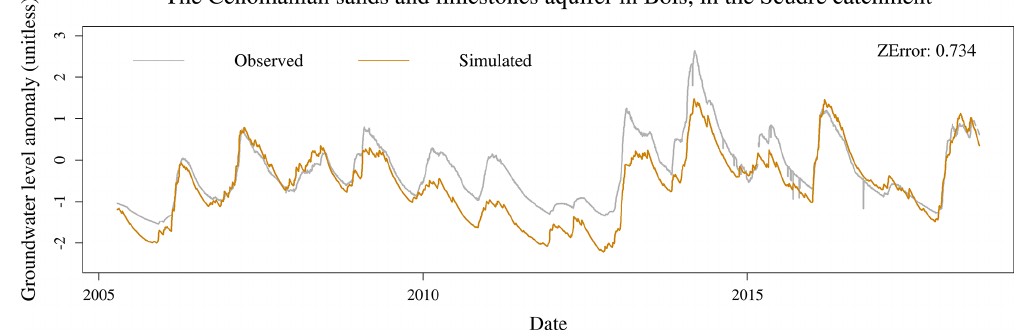
Figure 12. Observed and simulated groundwater levels in the Seudre catchment, where the simulated groundwater level was obtained with the new calibration frameworks: first piezometer.